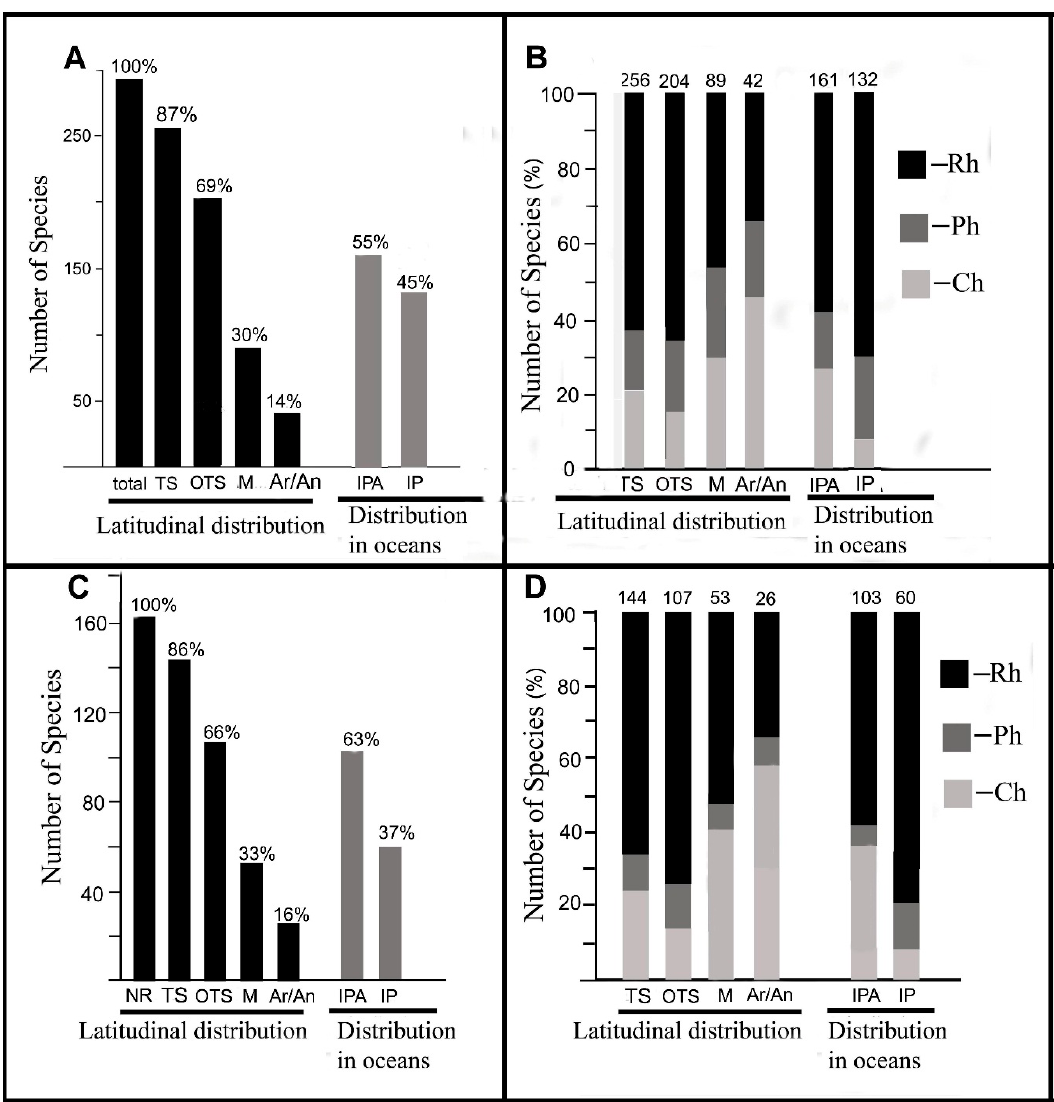
Figure 4. Absolute and relative number of algal species in the collection 2012 − 2017 in groups differing in geographic (latitudinal) distribution. ( A ) Species number in different algal groups of the collection 2012 − 2017. ( B ) Relative number of species from the Phyla Rh, Ch, and the Class Ph in different geographic groups of algae of the collection 2012 − 2017. ( C ) Algal species number in geographic groups of new findings, new records (NR) in the collection 2012 − 2017. ( D ) Relative algal species number in the Phyla Rh, Ch, and the Class Ph in different geographic algal groups of new findings in 2012 − 2017. TS, algae inhabiting tropical and subtropical seas (OTS); M, algae inhabiting the tropics